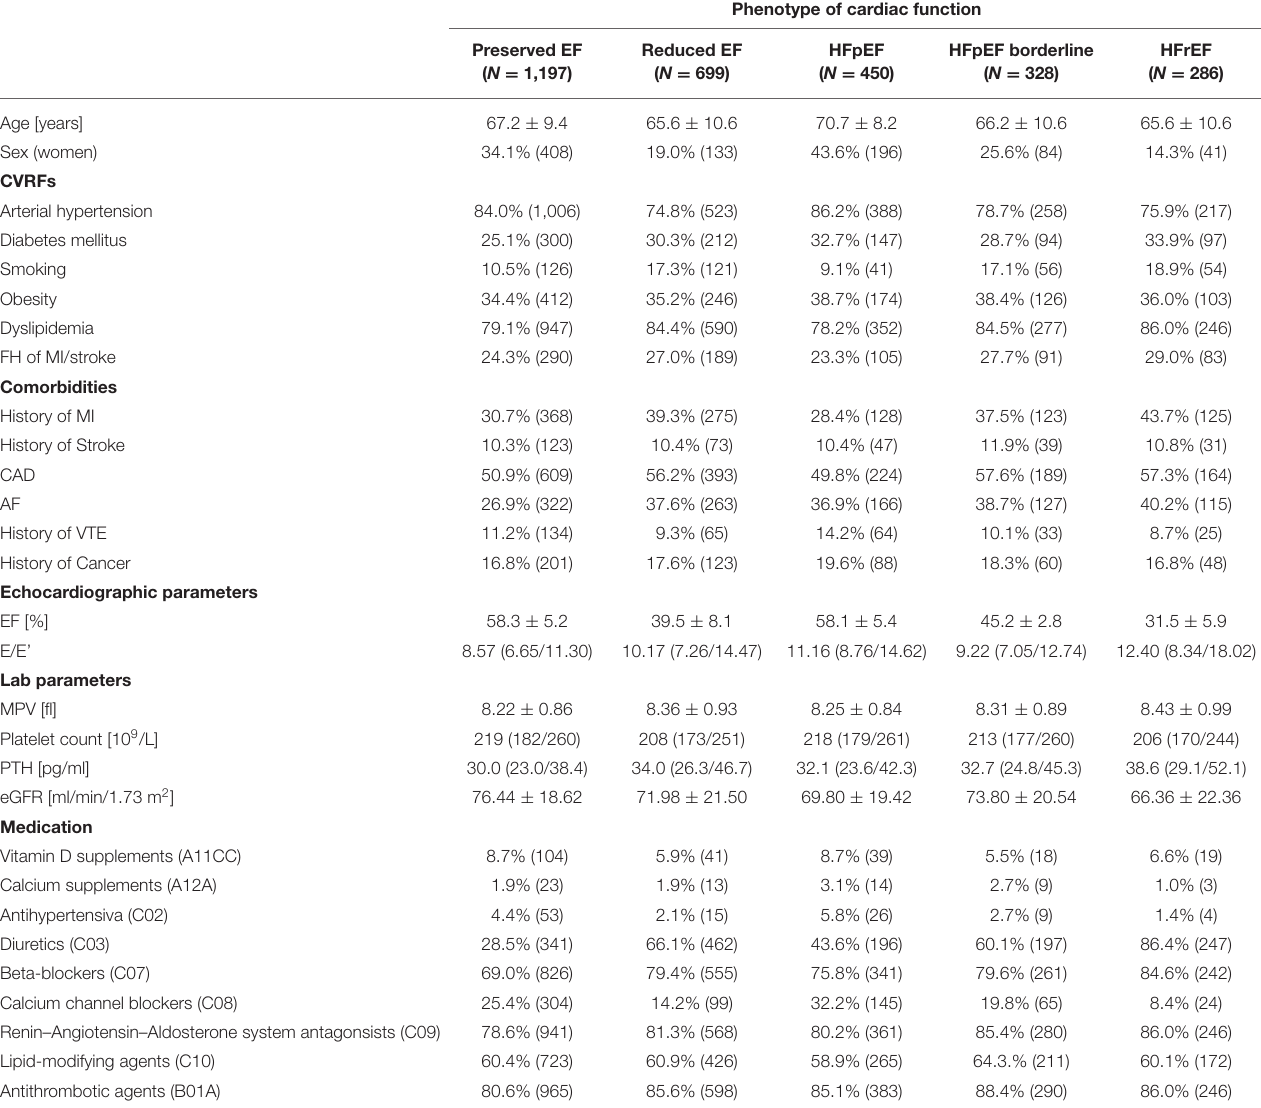
TABLE 1 | Baseline characteristics according to phenotype of cardiac function ( N =